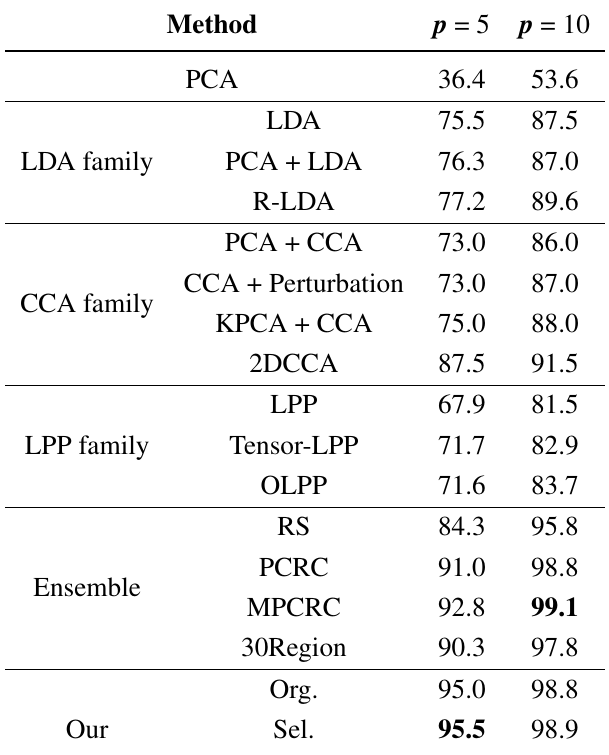
Table 2. Evaluation of the Yale2